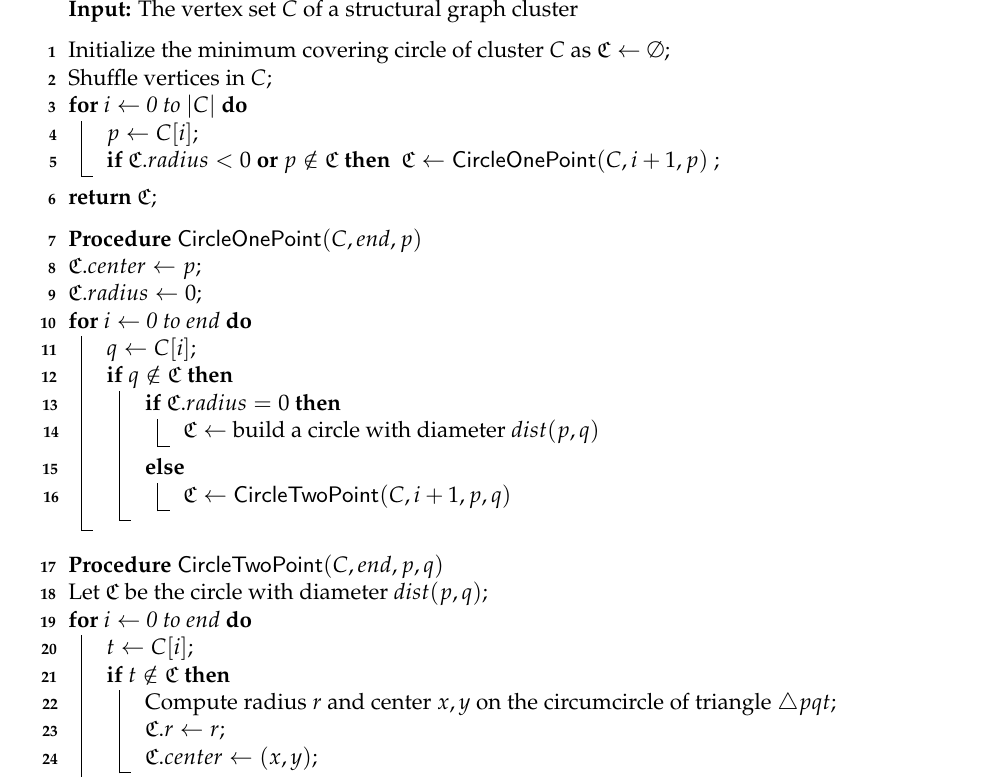
Algorithm 3: MCCRandom( C